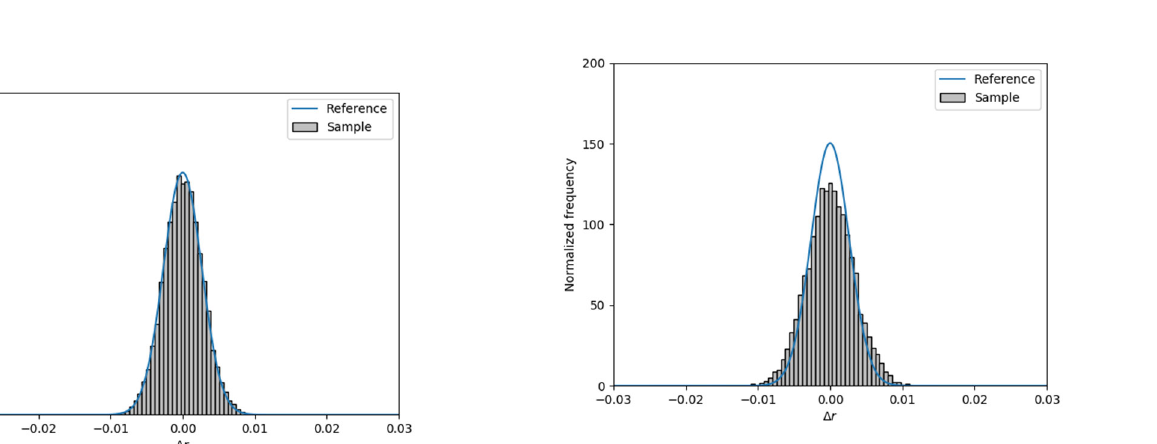
Fig. 5. Histogram of 𝛥𝑟 when ( 𝐕(cid:3553) 𝐦 (cid:3404) 10 (cid:2870) 𝐕 𝐦 )